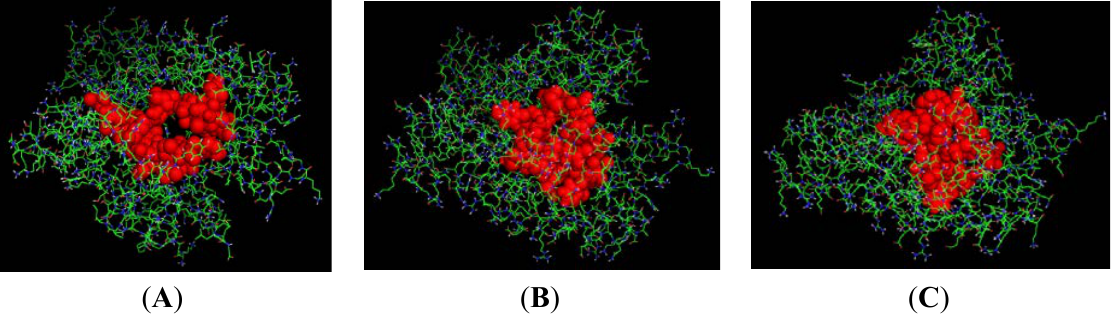
Figure 6. Projection of the predicted active site for ( A ) NBD protein; ( B ) K71L and